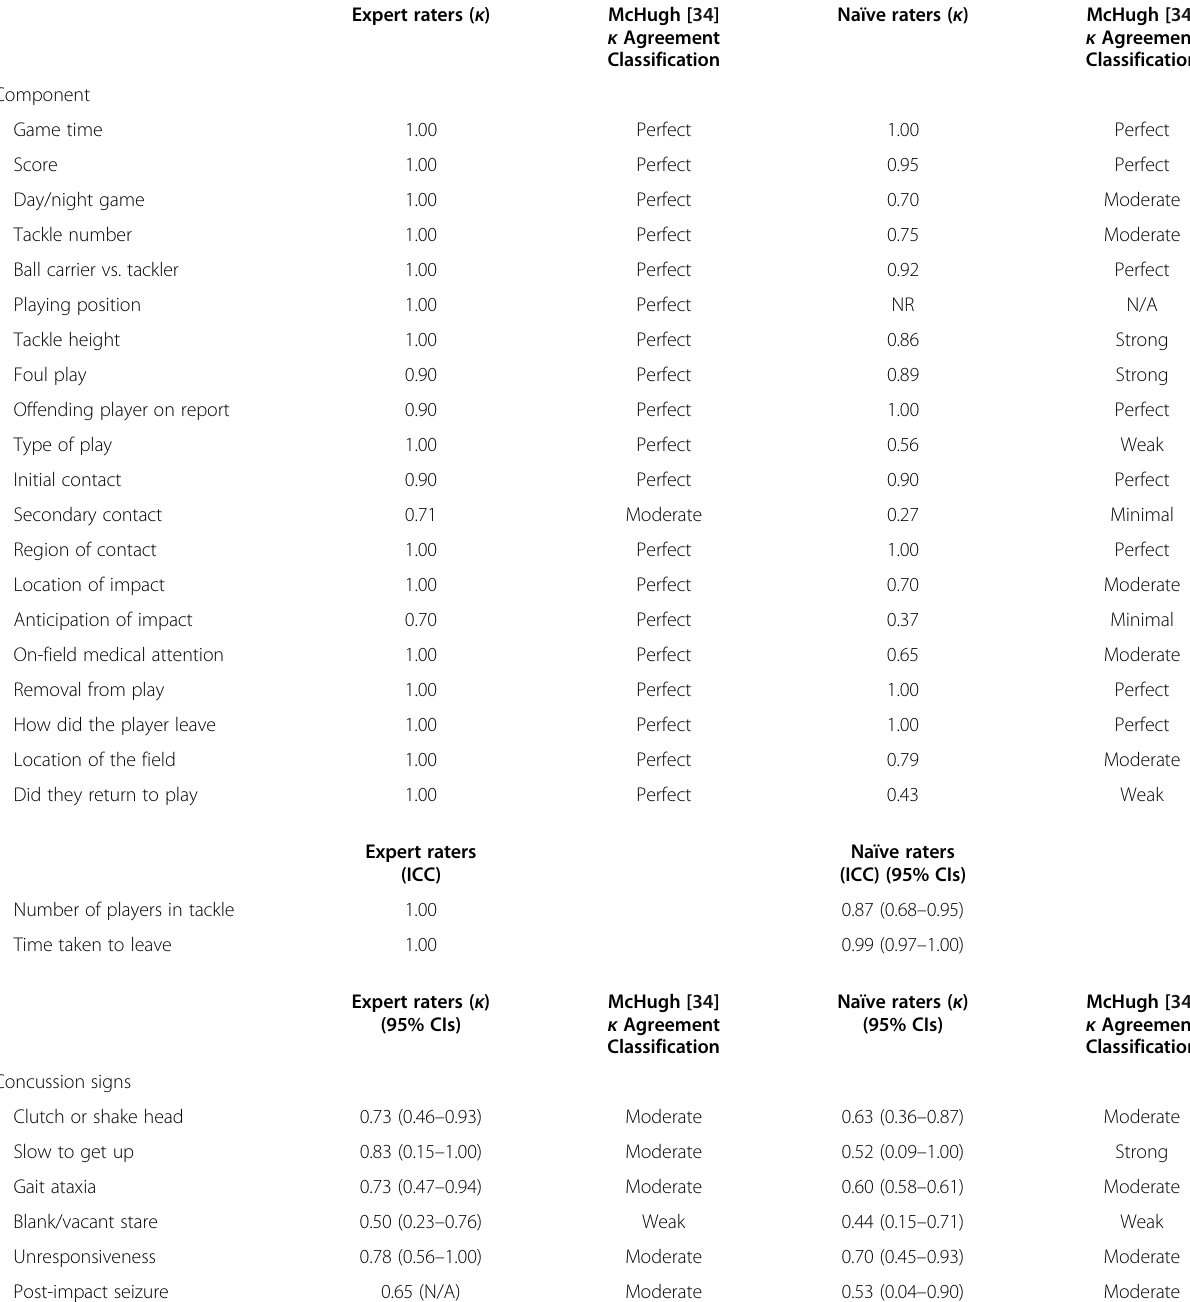
Table 1 Inter-rater reliability ( κ , ICC) for naïve and expert raters for each component of the